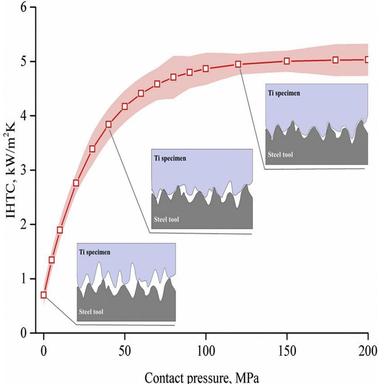
The predicted IHTC evolution between the Ti-6Al-4V and H13 as a function of contact pressure under dry conditions.